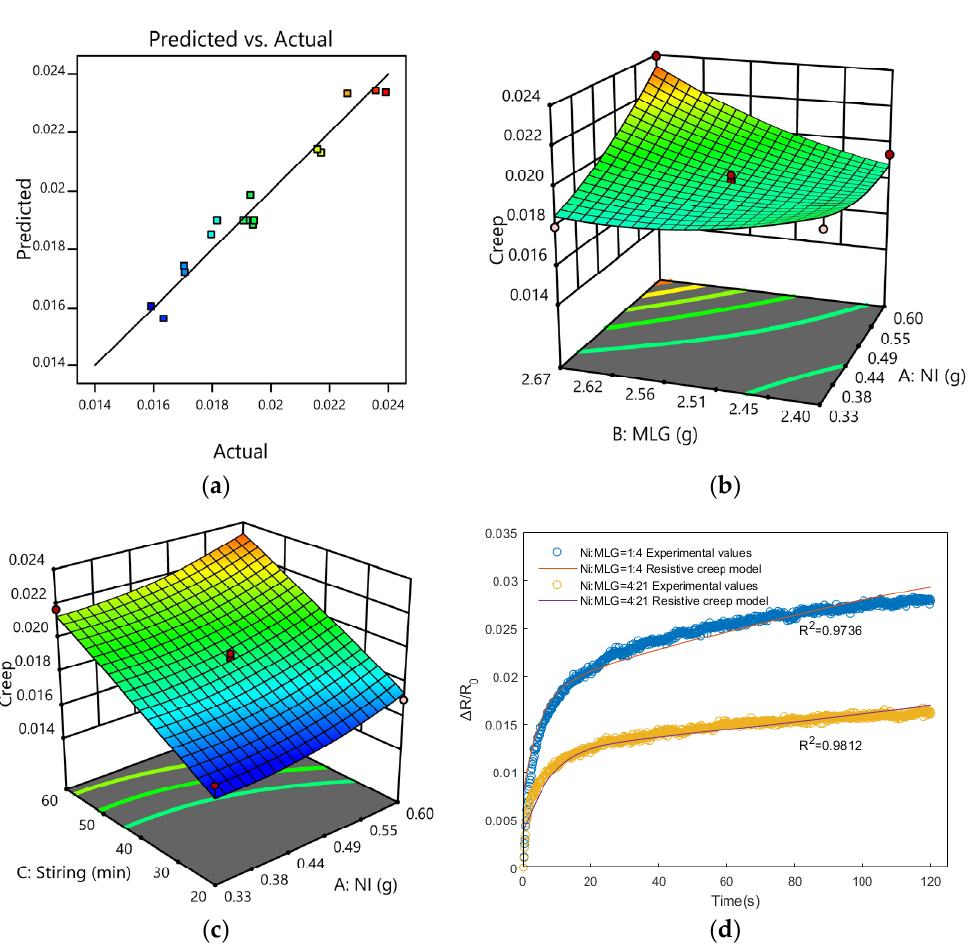
Figure 11. Graphs representing various optimization models: ( a ) experimental values and anticipated graphs; ( b ) nickel powder’s response surface to the influence of its interaction with graphene; ( c ) interaction effect response surface between stirring duration and nickel powder; ( d ) relationship between the observed values of creep for optimized ratios and pre-optimized ratios, on the one hand, and the theoretical values of the resistance creep model, on the other.